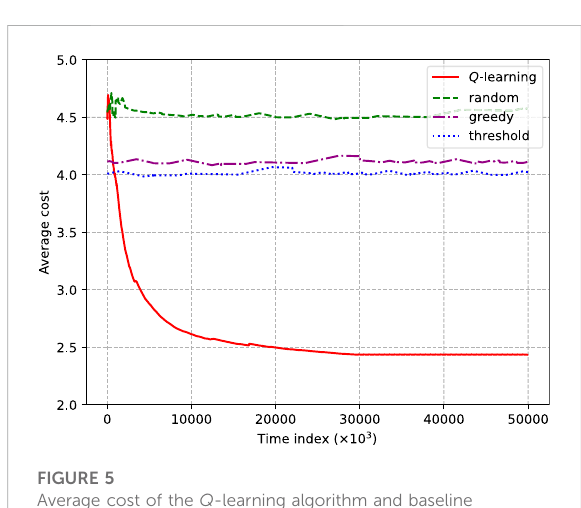
FIGURE 5 Average cost of the Q -learning algorithm and baseline policies with the ideal channel